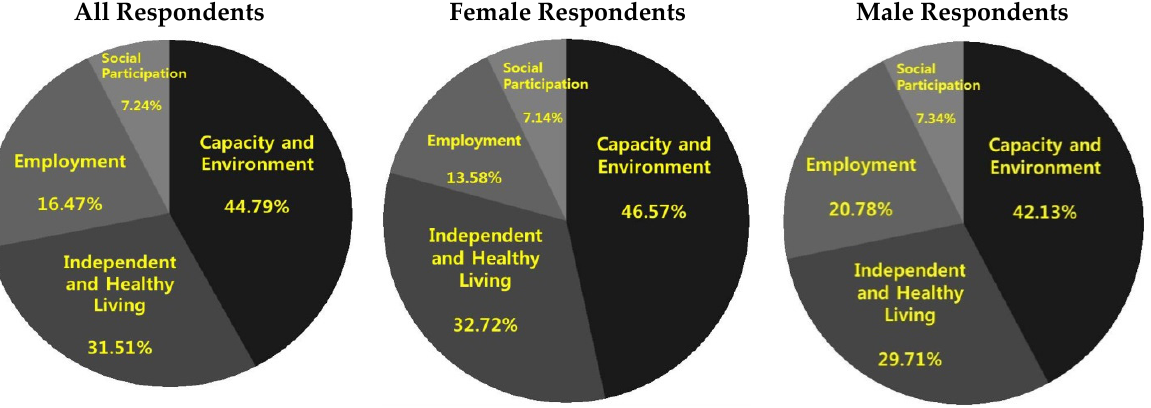
Figure 2. Components of the Healthy and Active Ageing Index.